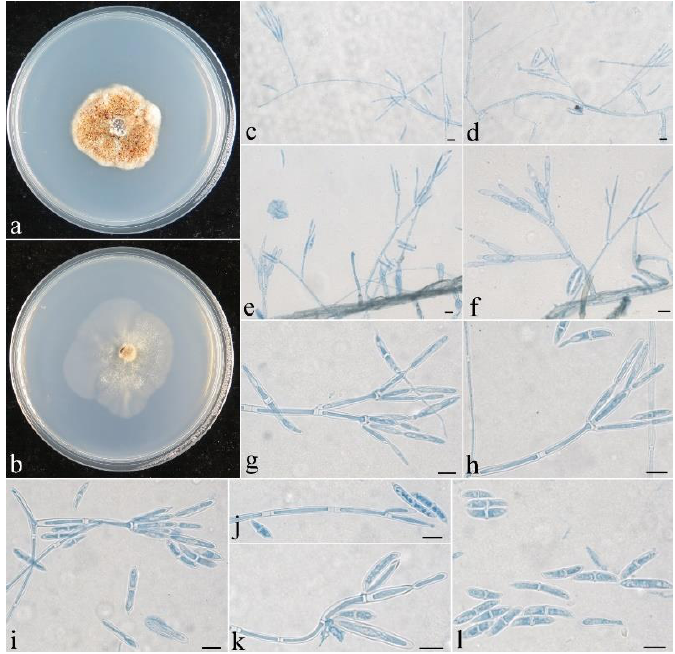
Figure 5. Colonial and microscopic morphology of Penicillifer sinicus (CGMCC 3.24130). ( a ) Colony after 1 week at 25 ◦ C on PDA; ( b ) colony after 1 week at 25 ◦ C on SNA; ( c – k ) conidiophores, phialides, and macroconidia in lactophenol cotton blue; ( l ) macroconidia in lactophenol cotton blue. Bars: ( c – l ) = 10 µ